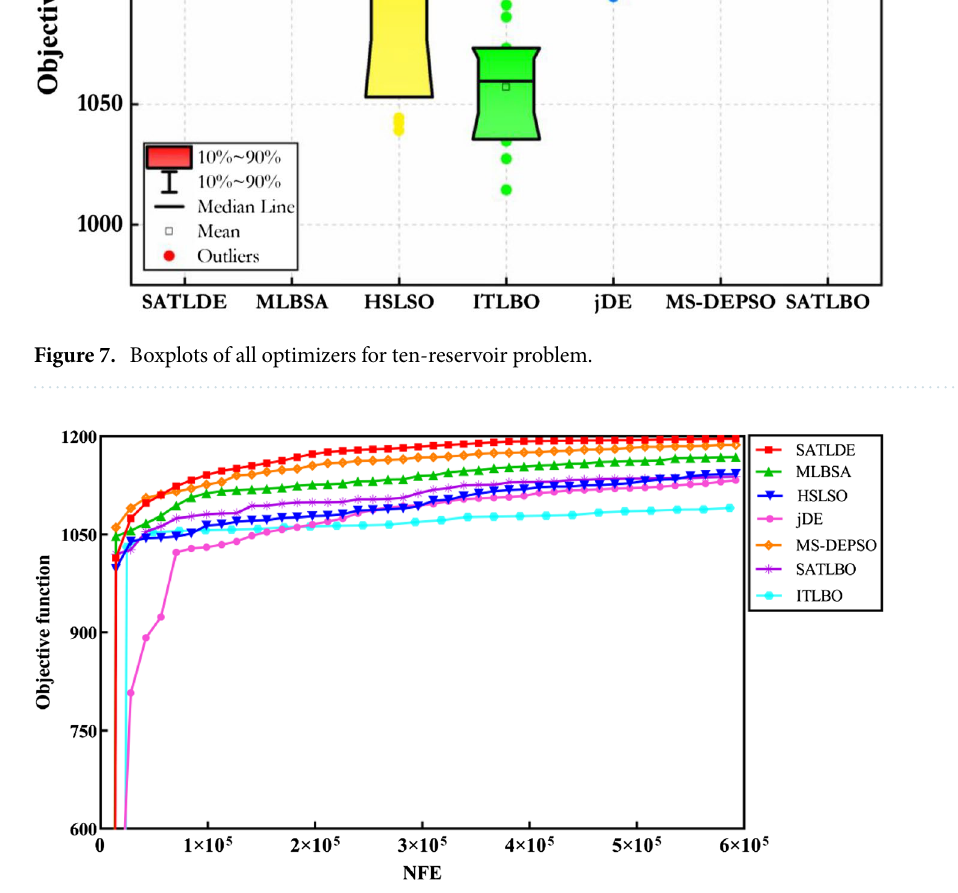
Figure 8. Convergence curves of all optimization techniques for ten-reservoir